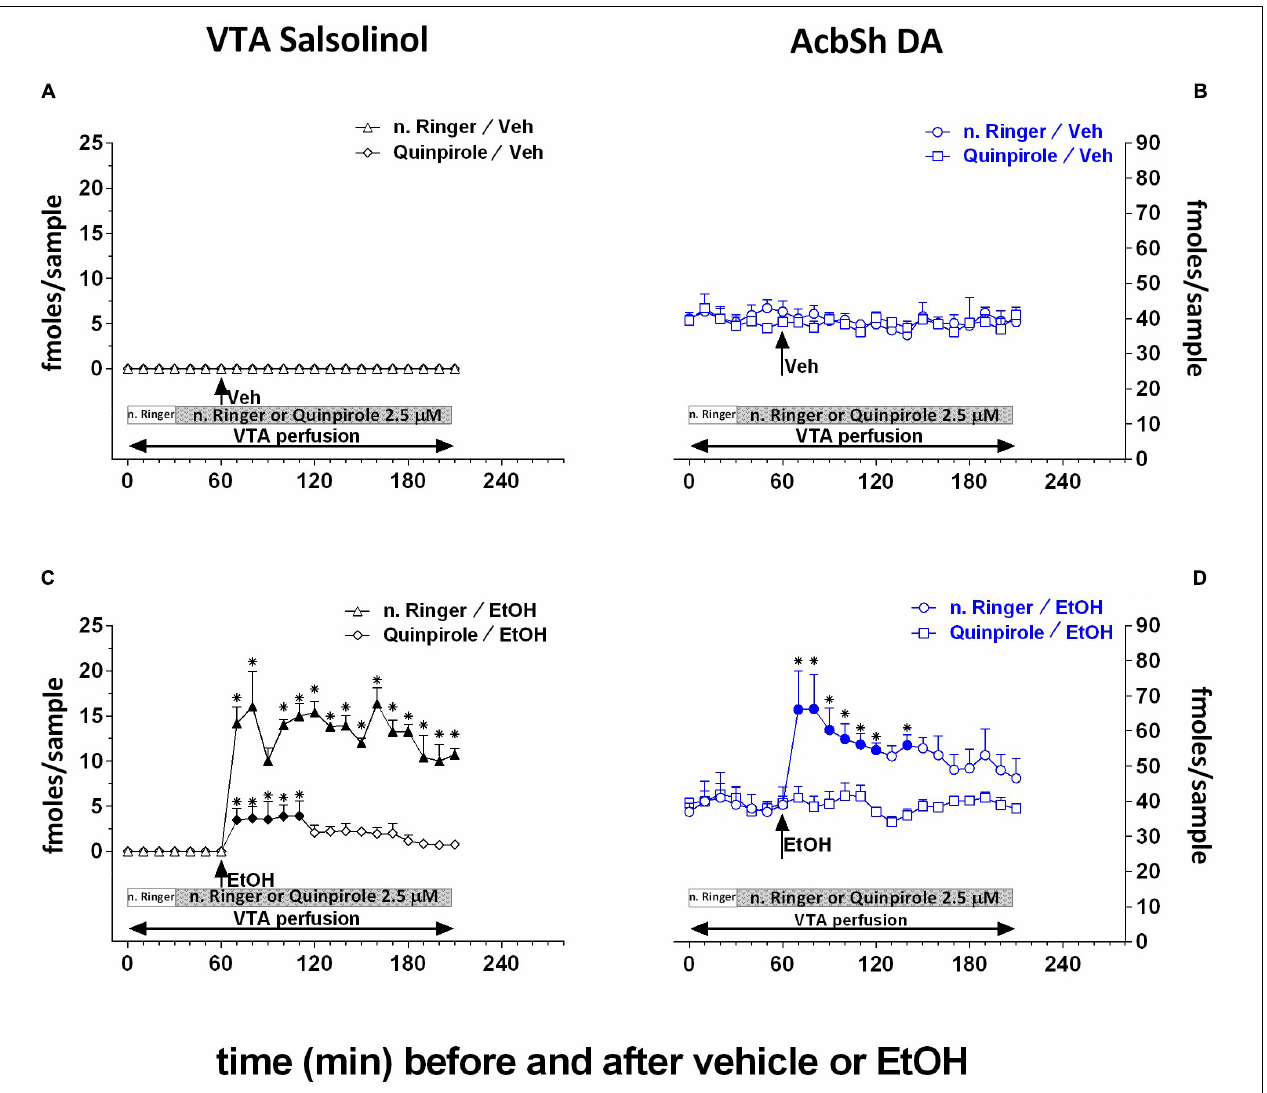
FIGURE 5 | Effects of intragastric administration of vehicle (tap water, 10 ml/kg) [ (A) N = 7, (B) N = 8] or ethanol (EtOH) (1 g/kg, 20% v/v) [ (C) N = 9, (D) N = 8] in the presence of reverse dialysis application in the pVTA, beginning 30 min before vehicle or EtOH administration, of normal Ringer ( n . Ringer) or quinpirole (2.5 µ M) on pVTA salsolinol [ (A,C) ; triangles: n . Ringer; lozenges: quinpirole] and on ipsilateral AcbSh DA dialysates [ (B,D) ; circles: n . Ringer; squares: quinpirole]. Horizontal bars depict the contents of the pVTA perfusion fluid along the experiment. Vertical arrows indicate the last pVTA or AcbSh microdialysis sample before vehicle or EtOH administration. Filled symbols indicate samples representing p < 0.001 vs. basal; * p < 0.05 vs.